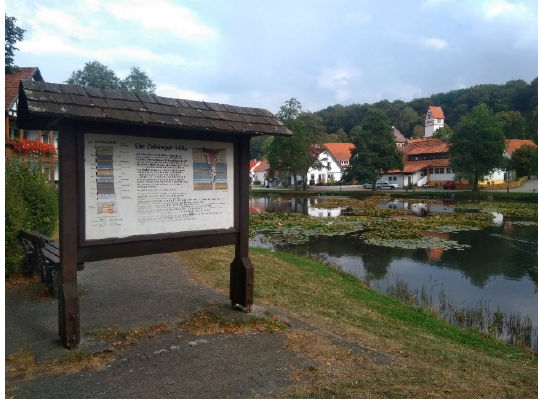
Figure 7. Village pond on volcanic vent in Zainingen (Author 2020).